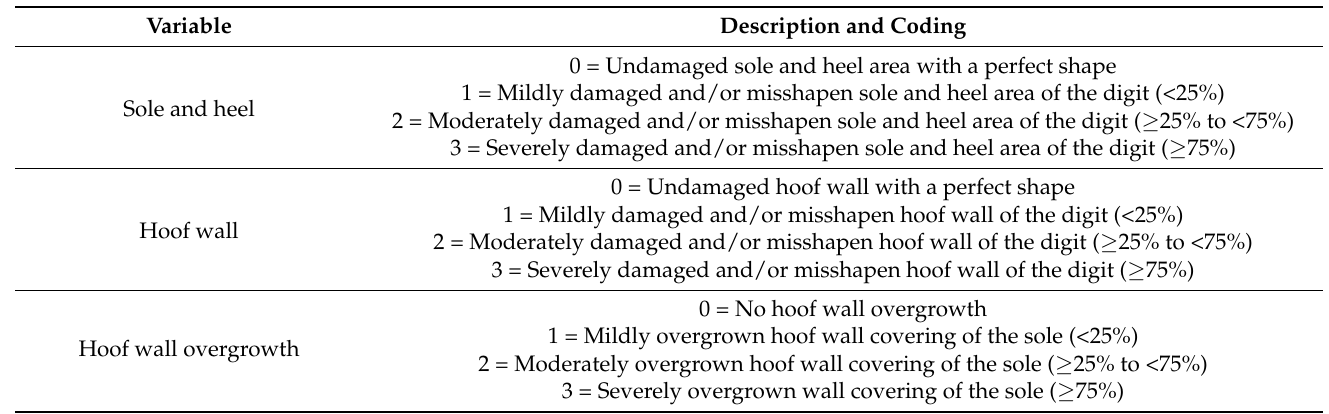
Table 2. Four-point ordinal scoring systems for three hoof conformation variables relating to sole and heel, hoof wall and hoof wall